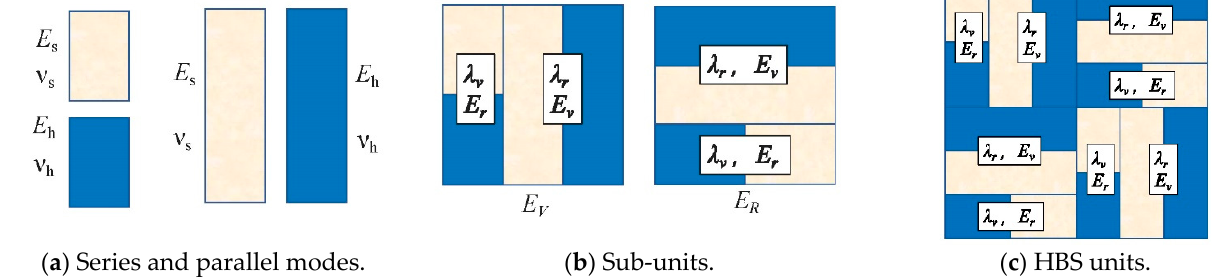
Figure 12. Two-phase elastic modulus model diagram.